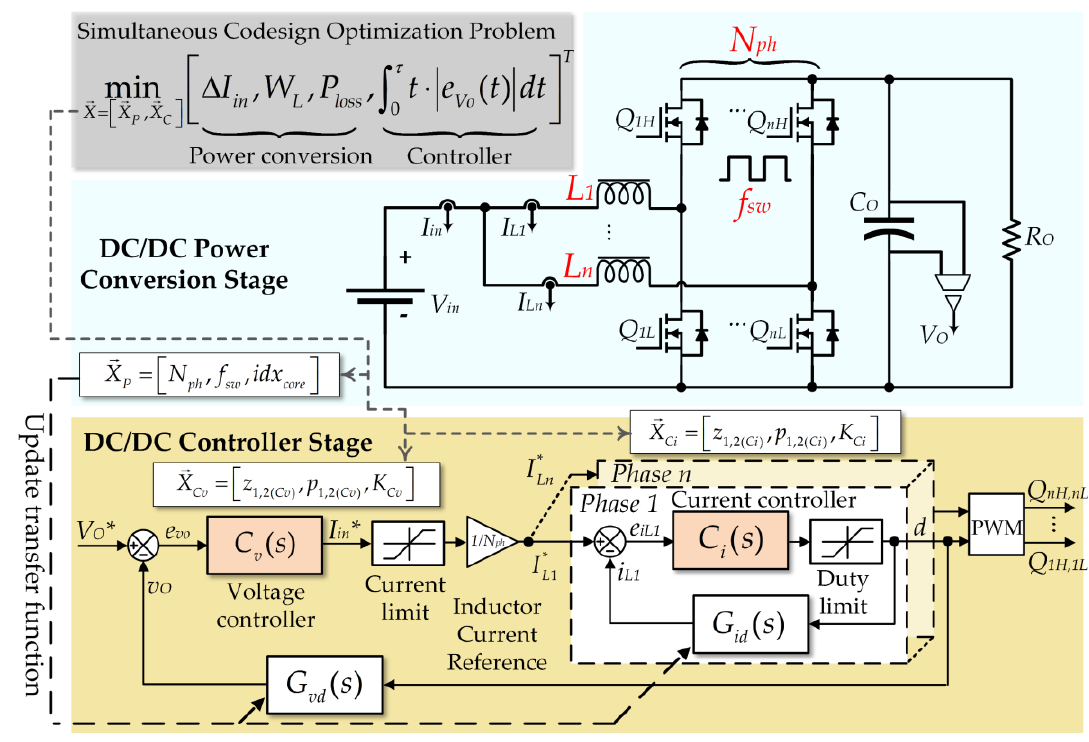
Figure 2. Block diagram of DC/DC power conversion stage and dual-loop control architecture.